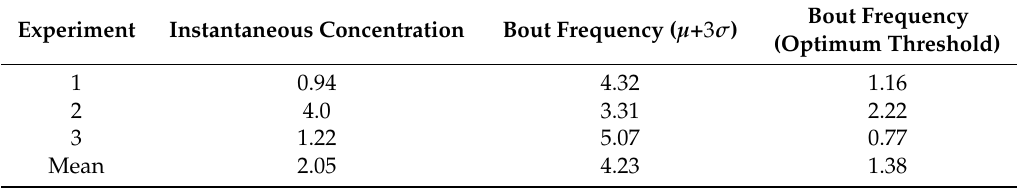
Table 2. Gas source localization error (m) in the three experiments, using the instantaneous concentration, the bout frequency with µ + 3 σ threshold or the bout frequency with optimum